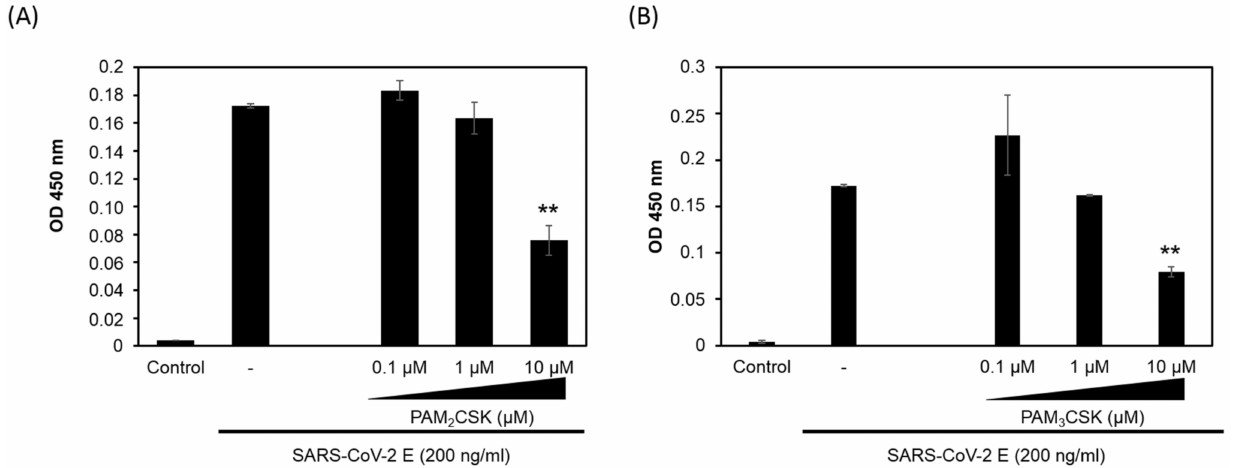
Figure 2. PAM2CSK4 and PAM3CSK4 interfere with SARS-CoV-2 E binding to TLR2. The speci- ficity of E–TLR2 interaction was evaluated by testing the capacity of TLR2 ligands ( A ) PAM2CSK4 (0.1–10 µ M) and ( B ) PAM3CSK4 (0.1–10 µ M) to inhibit this interaction. Statistical significance com- paring different groups is denoted with ** for p <